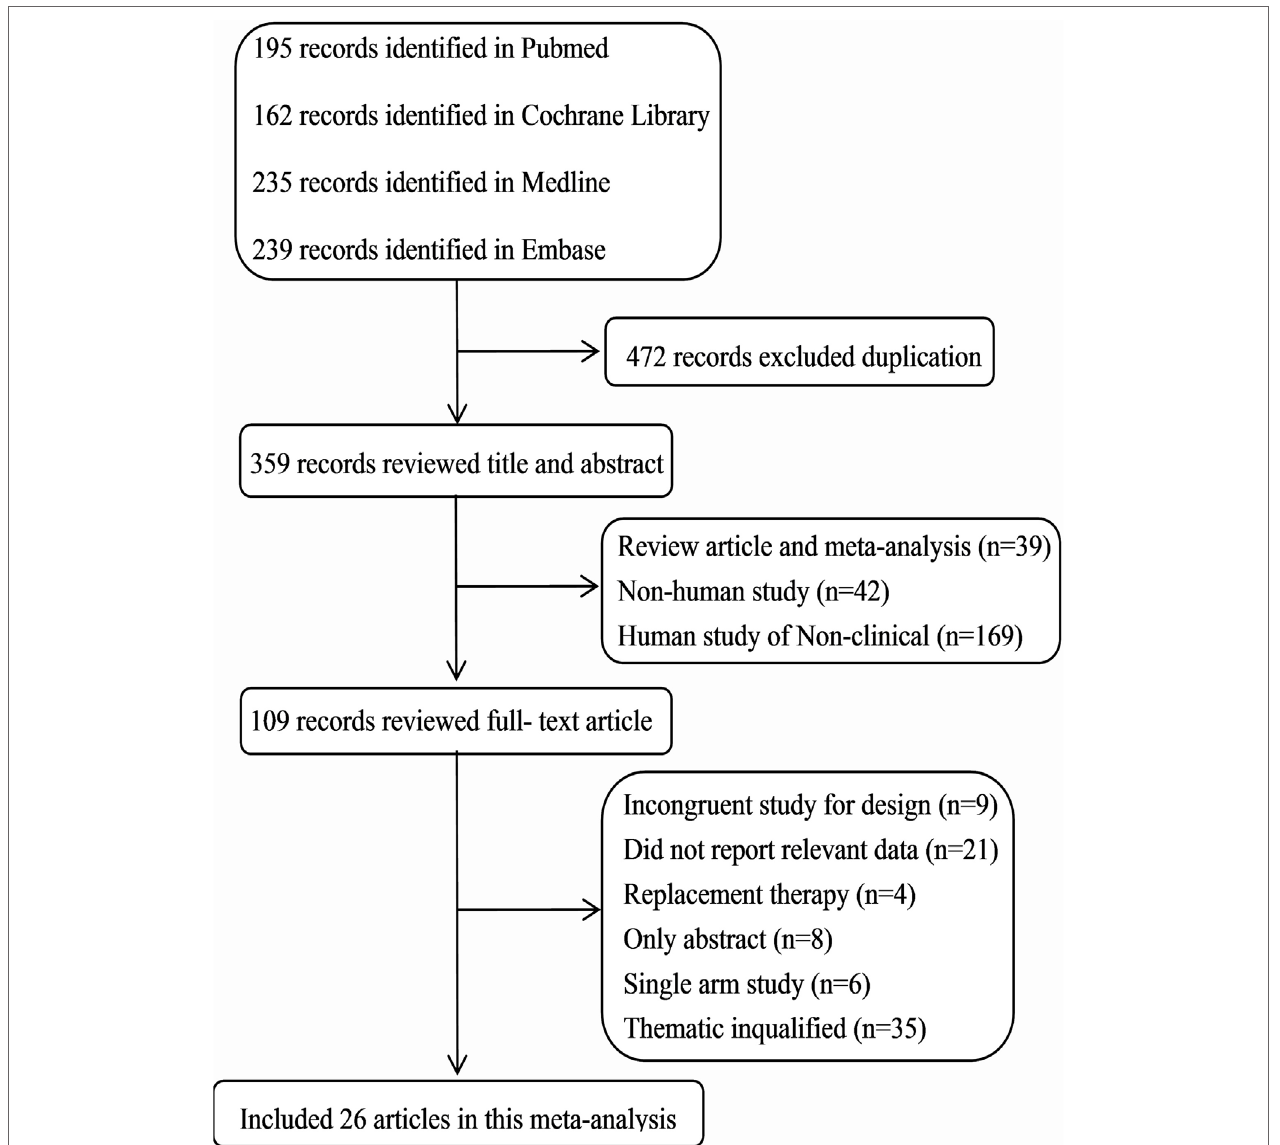
FIGURE 1 | Flow chart of selected